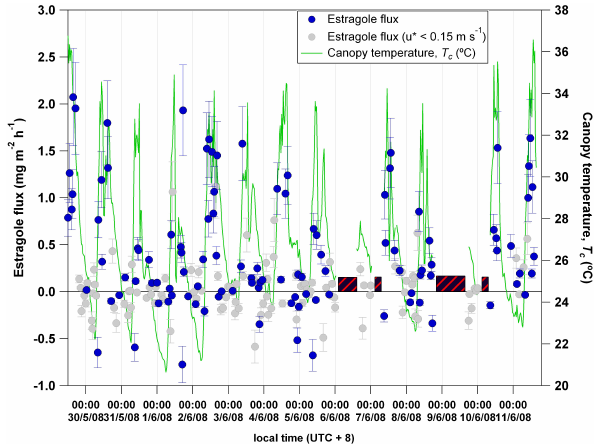
Fig. 5. Estragole flux with uncertainty bars (mean error estimated at 35%), and canopy temperature. Black/red areas refer to power